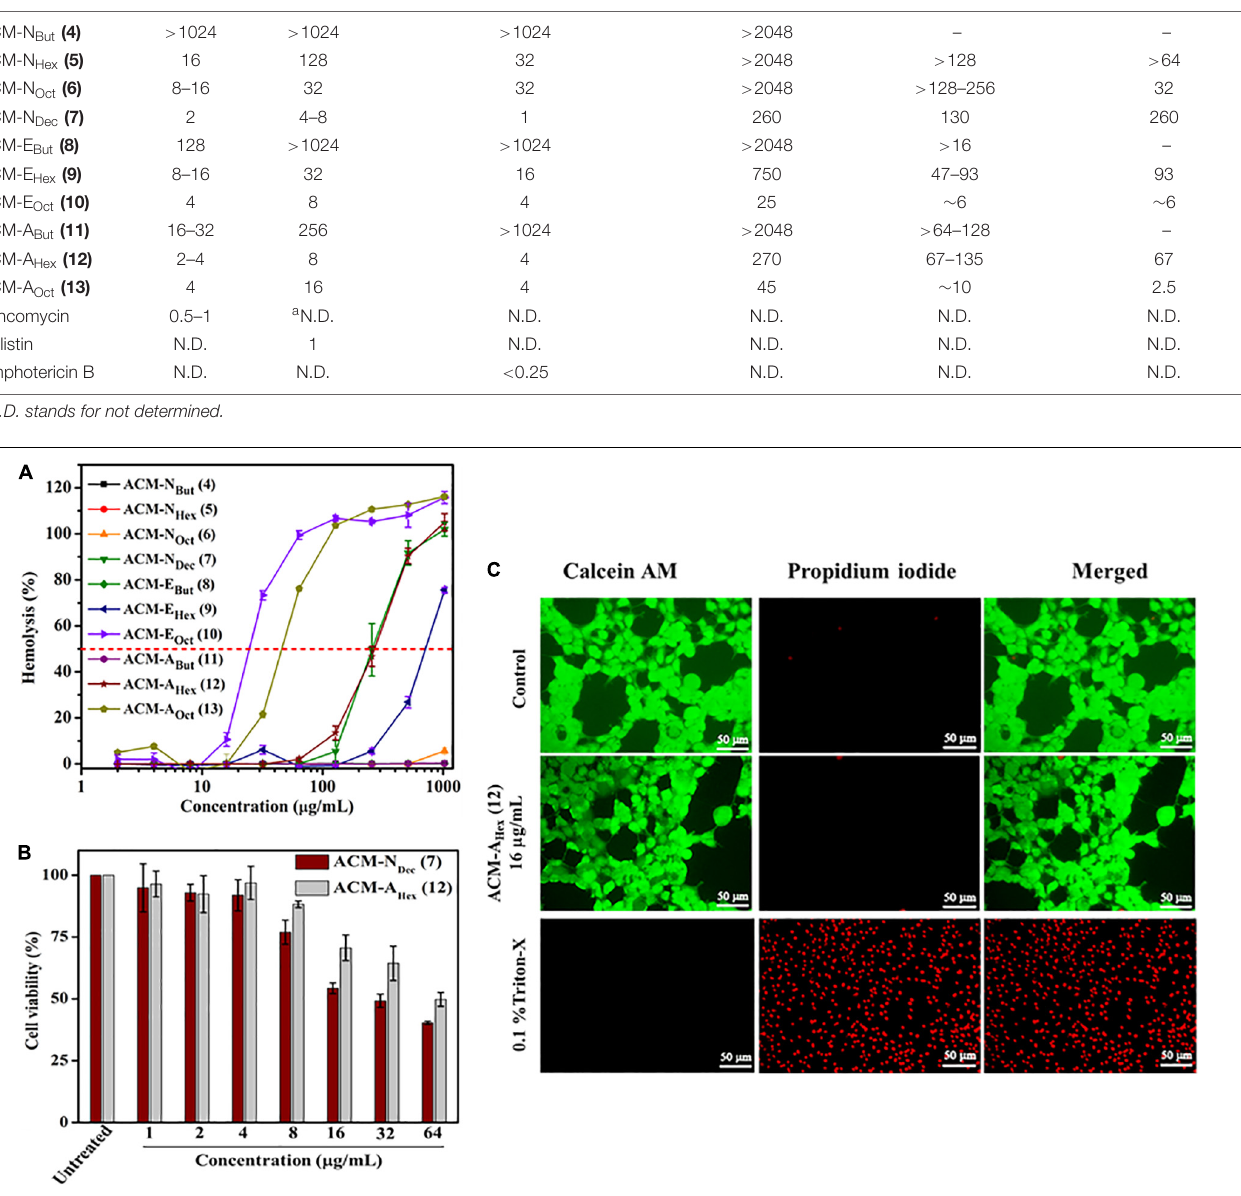
FIGURE 1 | In vitro toxicity of amphiphilic cationic macromolecules (ACMs): (A) toward human erythrocytes ( p < 0.0001, two-way ANOVA); (B) toward HEK-293 cells ( p = 0.0232, two-way ANOVA). Here each value represents average of three different experimental values and error bar indicates standard